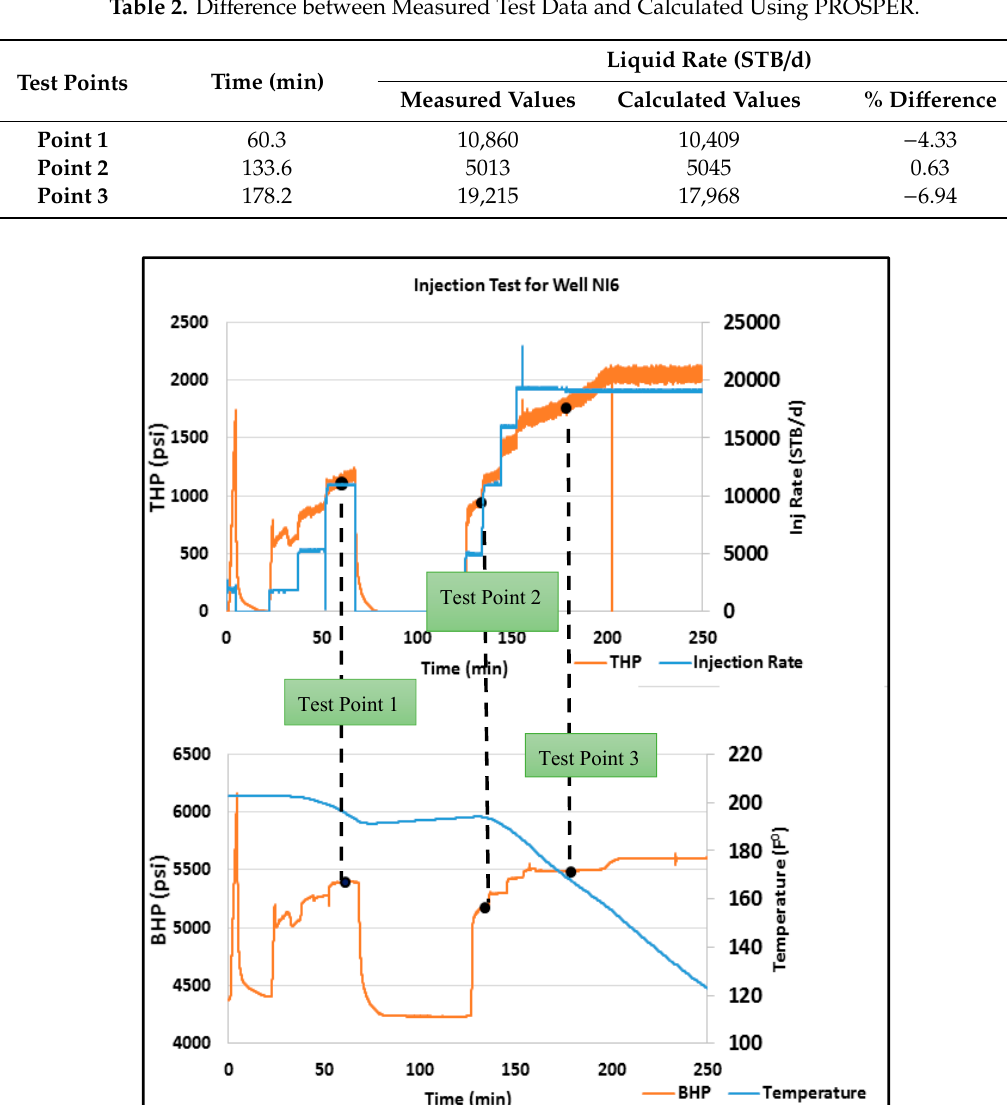
Figure 36. Injection test for Well NI6. Figure 35. Injection test for Well Table 2. Difference between Measured Test Data and Calculated Using PROSPER.